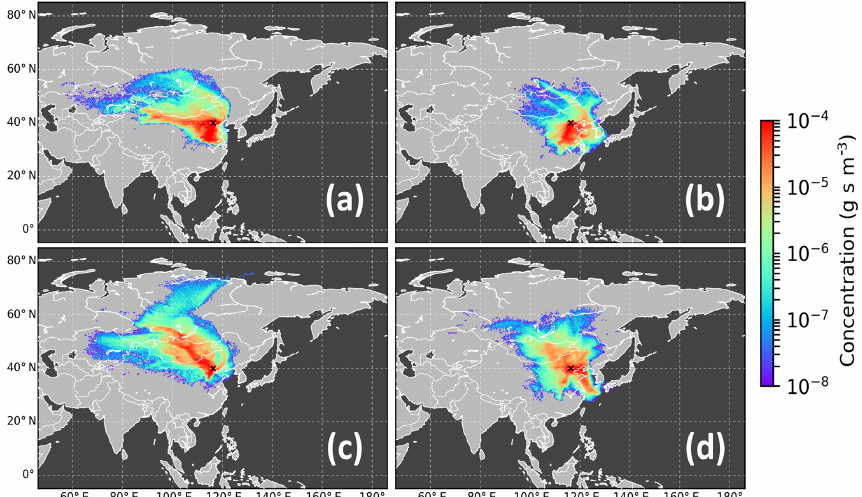
Figure 3. Sum of the 72h back trajectories for (a) winter, high-pollution days (WH), (b) summer, high-pollution days (SH), (c) winter, low- pollution days (WL), and (d) summer, low-pollution days (SL). The colours denote the relative (on a logarithmic scale) residence time of the air masses in each 0.25 ◦ × 0.25 ◦ grid box (up to 100m from the surface) during the last 72h before arriving at the monitoring station (the model calculates the concentration of theoretical air mass particles integrated over time per volume). The black cross denotes the sampling